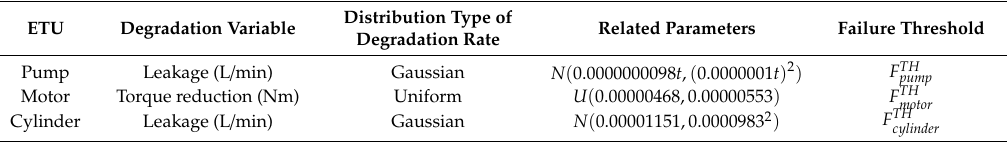
Table 1. Uncertainty